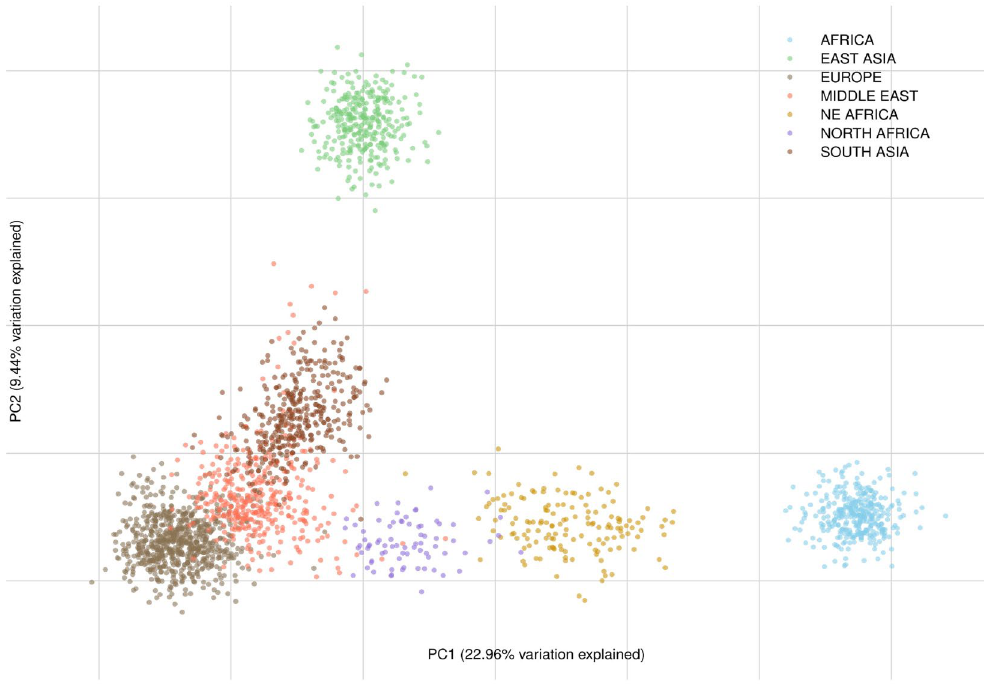
script written in R v. 3.5.0 using the ‘adegenet’ v. 2.1.2 and the ‘ade4’ v. 1.7-15 R packages 43,44